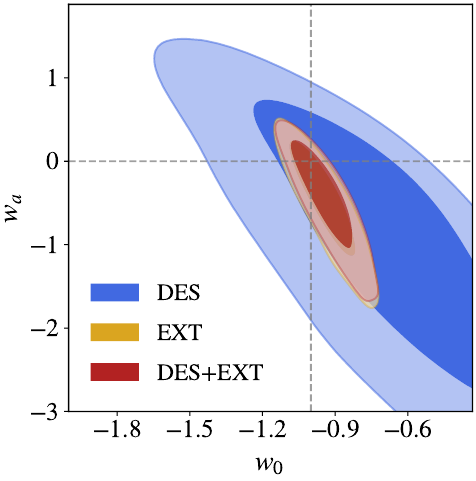
Figure 7. The contours show the 1- and 2- σ constraints for the dark energy equation of state parameters w 0 and w a of Equation (1) obtained from DES and other experiments. From Abbott et al. [20].